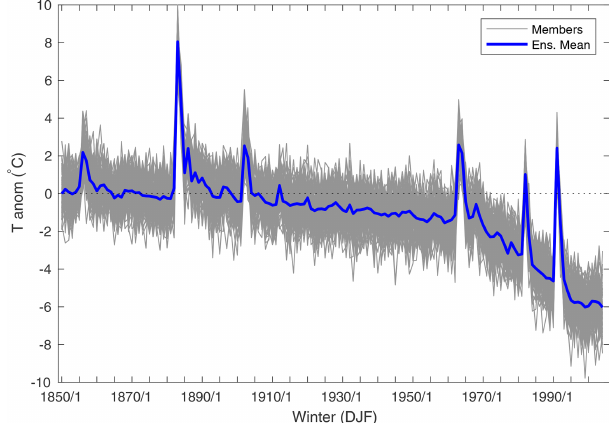
Figure 5. Tropical (30 ◦ S–30 ◦ N) temperature anomalies in DJF at 50hPa, in the MPI historical runs simulations, from 1850–51 to 2004–05. The gray lines represent individual members, and the blue line represents the ensemble mean. Here, anomalies are defined based on the 1861–1880